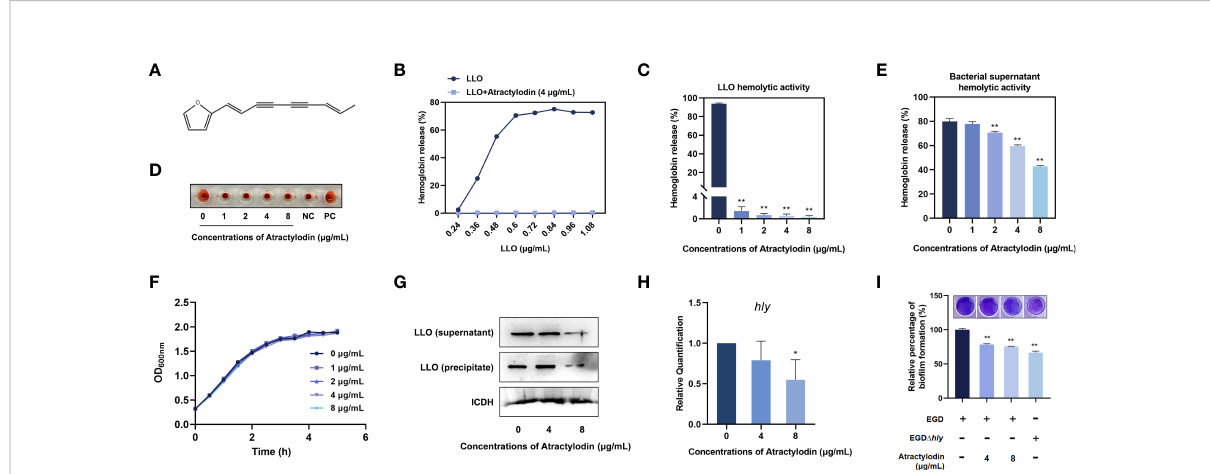
FIGURE 1 Atractylodin observably inhibited LLO function. (A) Chemical structure of atractylodin. (B) Inhibition of atractylodin on indicated concentrations of LLO-mediated hemolytic activity. Hemolytic activity of LLO (C) and the supernatants of L. monocytogenes EGD cultures (E) pre-incubated with or without atractylodin. (D) A corresponding visual image of inhibitory effect of atractylodin on LLO-mediated hemolytic activity. The hemolytic activity was represented as value obtained at OD 570nm , and RBCs treated with ddH 2 O sample served as a positive-control (PC) and untreatment RBCs sample served as a negative-control (NC). (F) Growth curves for the L. monocytogenes EGD co-cultured with indicated concentrations of atractylodin. (G) Western blotting analysis of LLO expression in cultured supernatant and precipitate. ICDH was acted as an internal control. (H) Inhibition of the transcription of the genes hly encoding LLO by atractylodin was evaluated by RT-qPCR analysis. (I) Quanti fi cation of bio fi lm biomass by crystal violet (CV) staining. All of the data are representative of three independent experiments and presented as the mean ± SEM. * P < 0.05, ** P <